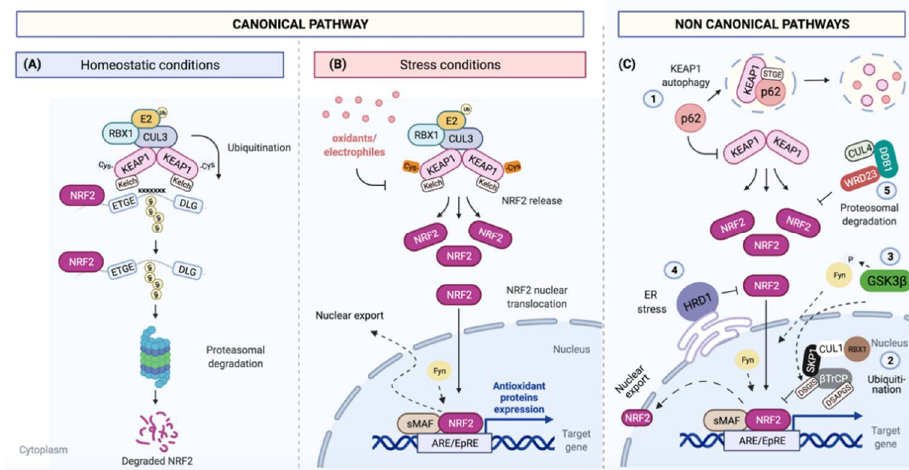
Figure 3. Canonical and non-canonical NRF2 pathways. ( A ) Under basal conditions, NRF2 ETGE/DLG motifs bind to KEAP1 Kelch domains. Binding to KEAP1 brings the CUL3/RBX1 E3 ubiquitin ligase into the complex and targets NRF2 for poly-ubiquitination and degradation by 26S proteasome. ( B ) Several oxidative and electrophilic stressors can modify critical KEAP1 cysteine residues, disrupting the KEAP1-NRF2 complex. As a consequence, NRF2 protein levels increase, causing its translocation into the nucleus where it forms a heterodimer with sMAF transcriptional factors to act on ARE/EpRE enhancer sequences for the control of its transcriptional program. Af- terwards, NRF2 is exported to cytoplasm upon phosphorylation by different Src family kinases, such as Fyn. ( C ) NRF2 can be also regulated by KEAP1-independent mechanisms: (1) by p62/SQSTM1, which promotes KEAP1 autophagic degradation via its STGE binding motif; (2) by β-TrCP that can form a complex with CUL1/SKP1, promoting NRF2 ubiquitination and degrada- tion; (3) by GSK-3β, which can phosphorylate β-TrCP, increasing NRF2 ubiquitination; (4) by HRD1, which can interact under reticulum stress conditions with Neh4 and 5 domains and trigger NRF2. Recently, (5) CUL4/DDB1/WDR23 was discovered as another E3 ubiquitin ligase to regulate NRF2, but its mechanism is still unclear.